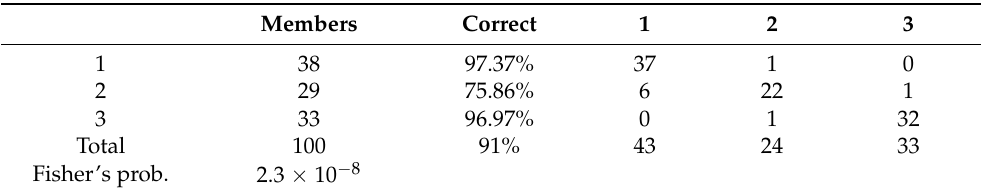
Table 5. Misclassification table from OPLS-DA modeling of the overall model (whole database) where 1 = Maurolia (Messinia), 2 = Lianolia Kerkyras (Preveza), and 3 = Koroneiki (Preveza).